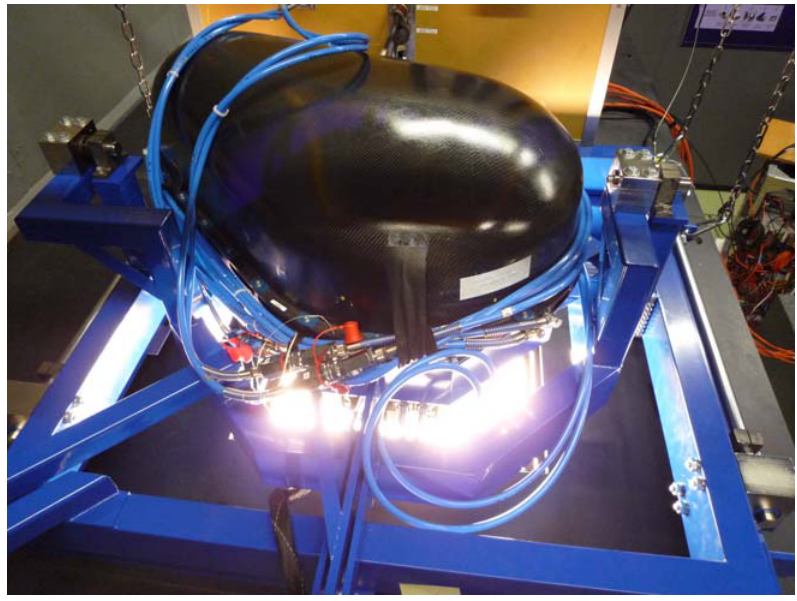
Figure 3. APEX installation on the integrating sphere at DLR for radiometric